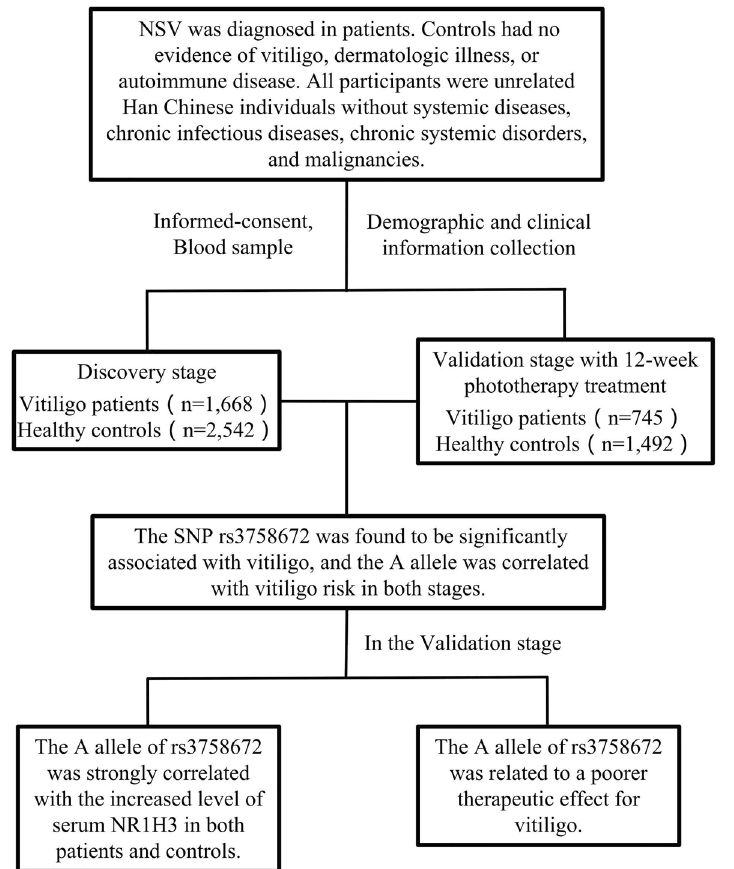
Figure 1. Flowchart of the study and participants’